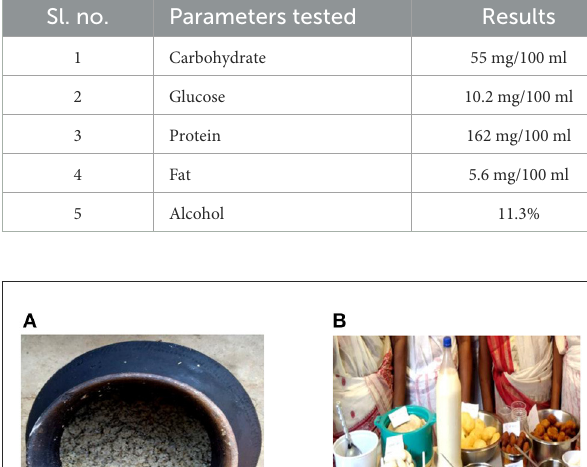
TABLE 6 Nutrient content of handia (raw). Sl. no.